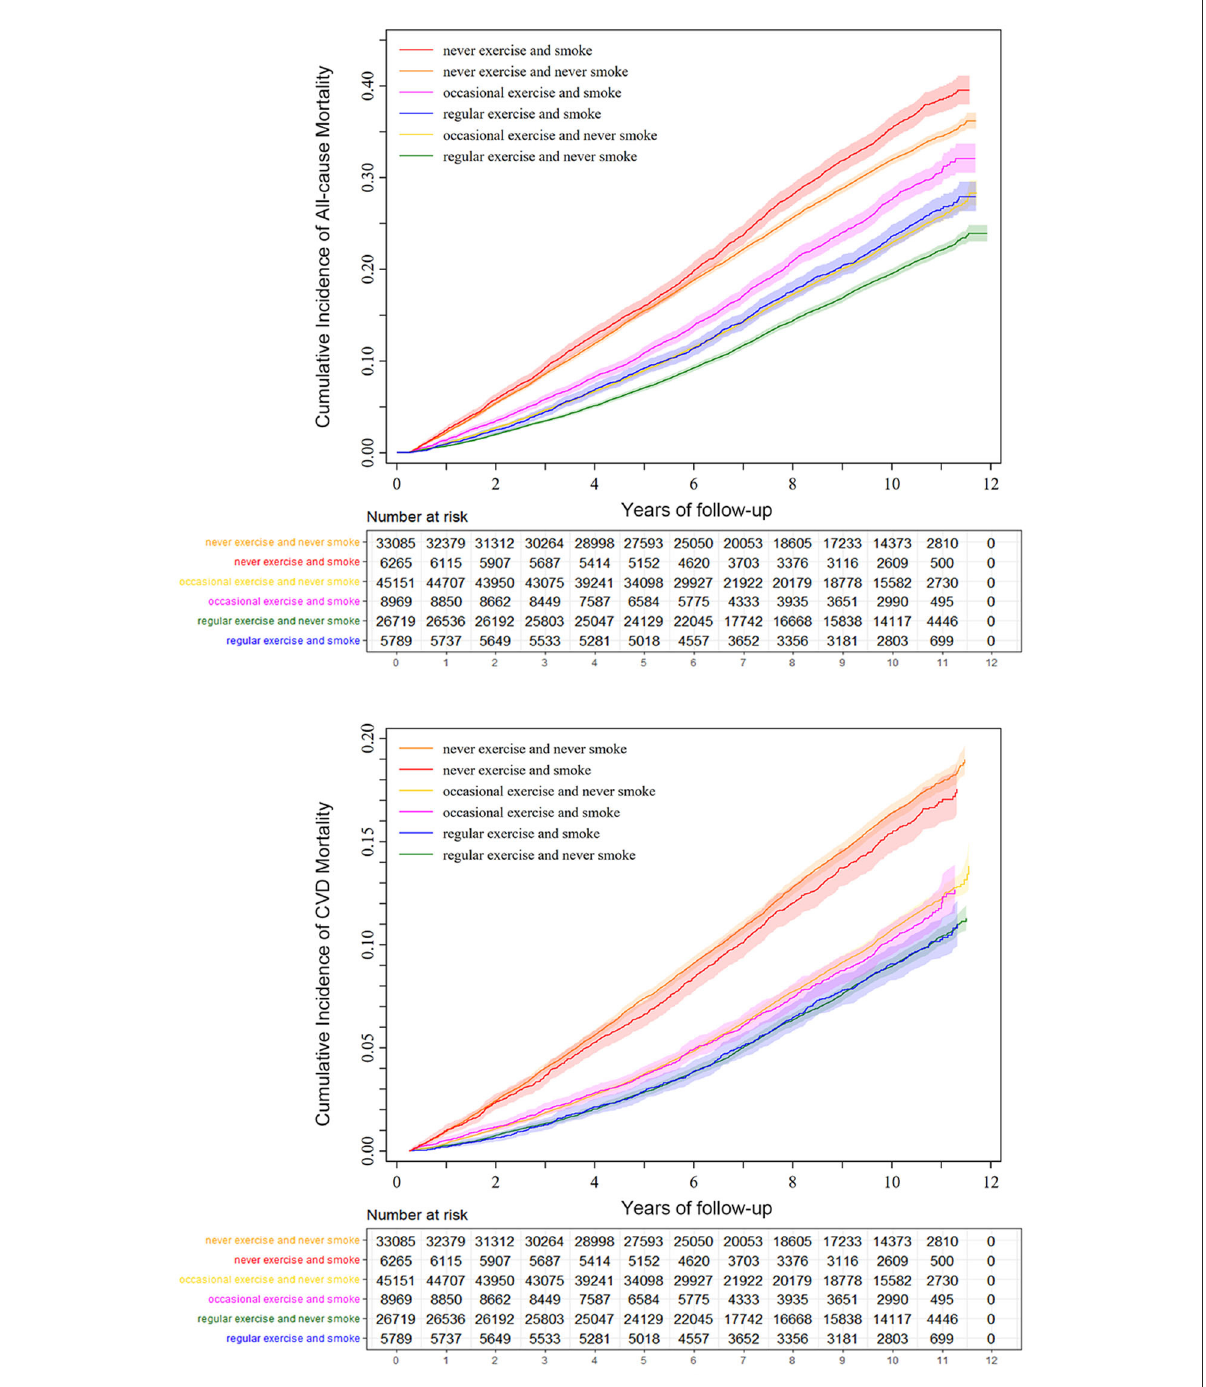
FIGURE2 Cumulative incidence and corresponding 95% CI of all-cause and CVD mortality by smoke and exercise. Estimation of CVD mortality accounted for competing risk treating non-cardiovascular deaths as competing events.